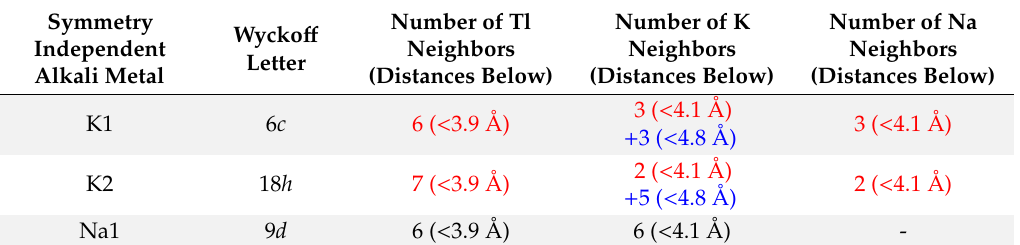
Table 7. Surrounding atoms of the symmetry inequivalent rubidium positions in Na 3 K 8 Tl 13 (space group R -3 m ). The color-coding refers to the color of the contacts in Figure